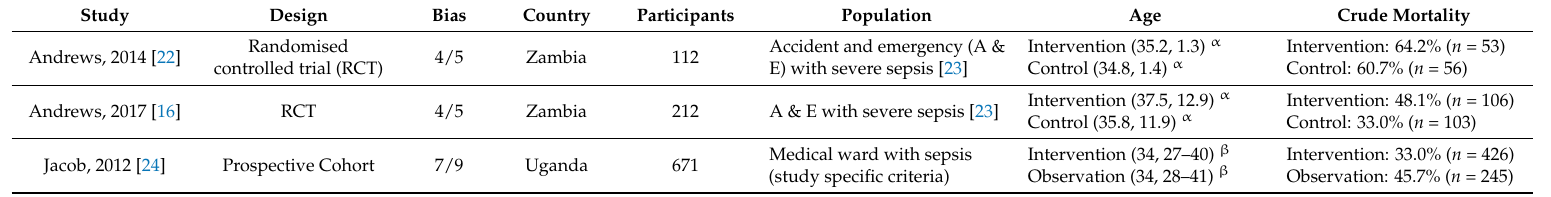
Table 1. Interventional studies that describe early goal-directed therapy for sepsis in sub-Saharan Africa.